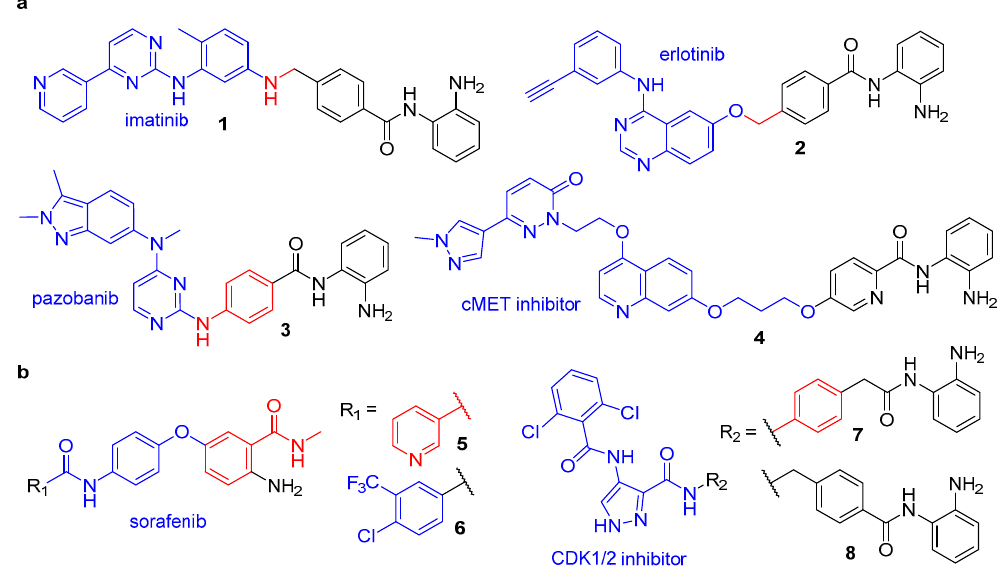
Figure 4. Class-I-selective HDAC dual inhibitors targeting ( a ) receptor tyrosine kinases and ( b ) other kinases. Components: kinase inhibitor (blue), HDAC inhibitor (black) and shared structural components (red).